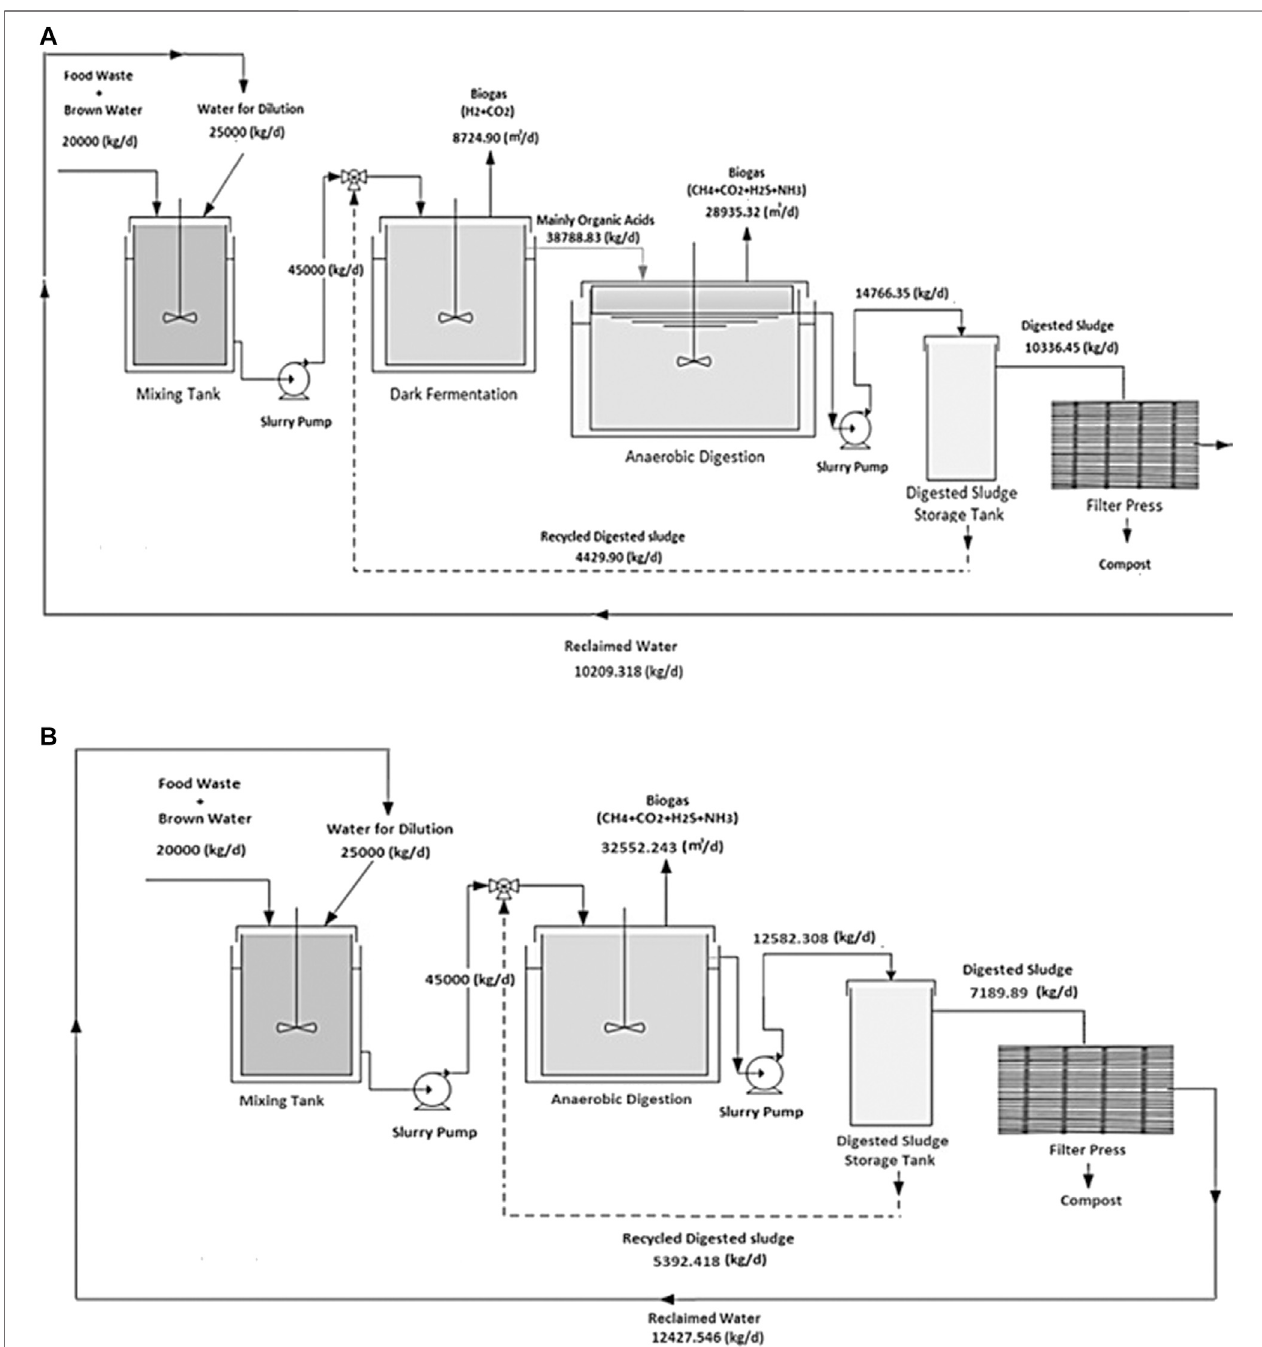
FIGURE 5 | A schematic of waste processing portions of the ammonia production processes through (A) two-stage DF coupled with AD and (B) AD-only.